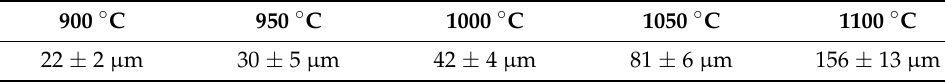
Figure 3. OM morphology of experimental steel annealed at different temperatures for 15 min. ( a ) 900 °C; ( b ) 950 °C; ( c ) 1000 °C; ( d ) 1050 °C; and ( e ) 1100 °C. Table 1. Grain size at different annealing temperature.